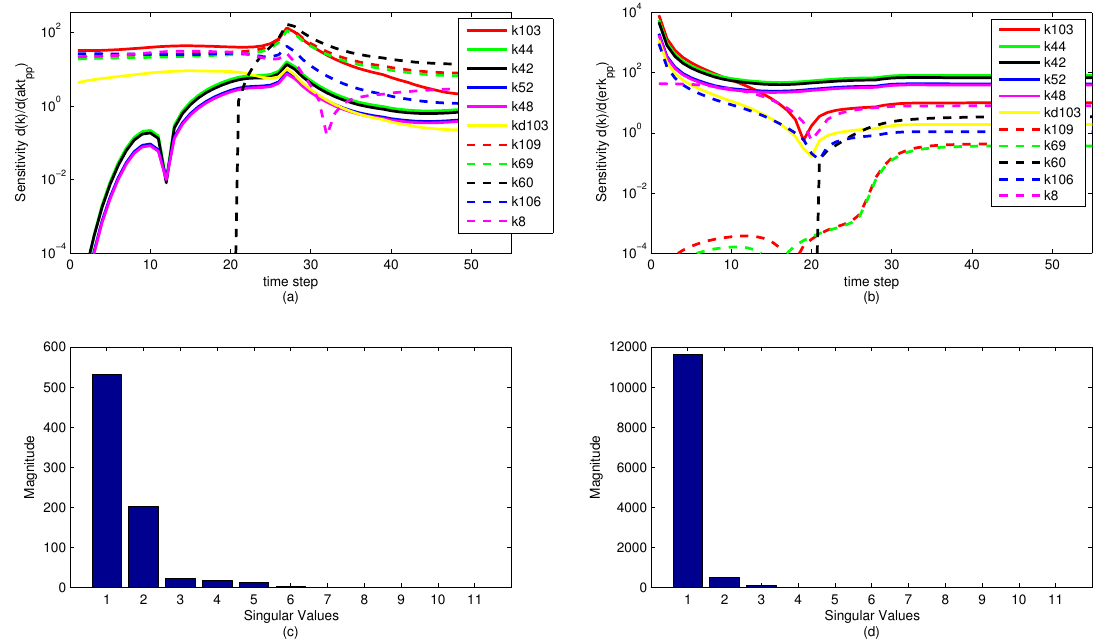
Figure 13. Parameter sensitivity over the time horizon (subplots a and b ) and singular value magnitudes for principal parameter search directions (subplots c and d ). The relative levels of the singular values show that some parameters have a strong effect on the predictions while others have a minimal effect or are co-linear and do not need to be